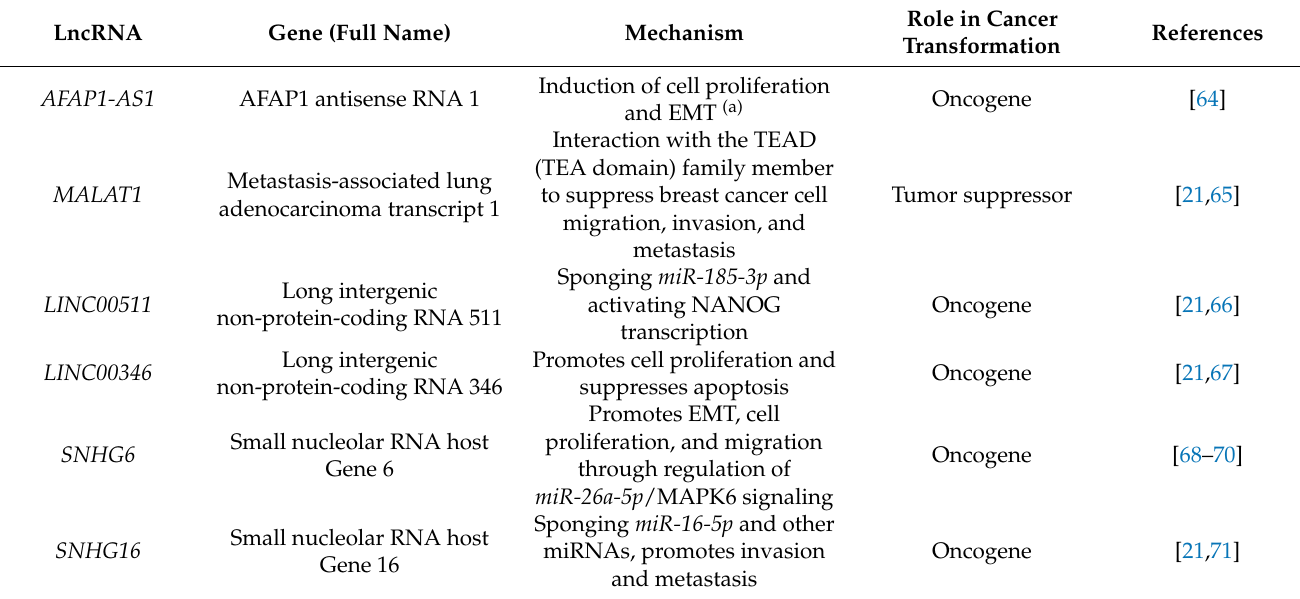
Table 1. Long noncoding RNAs that were documented to mediate the effect of vitamin D3 in breast cancer through their interaction with vitamin D